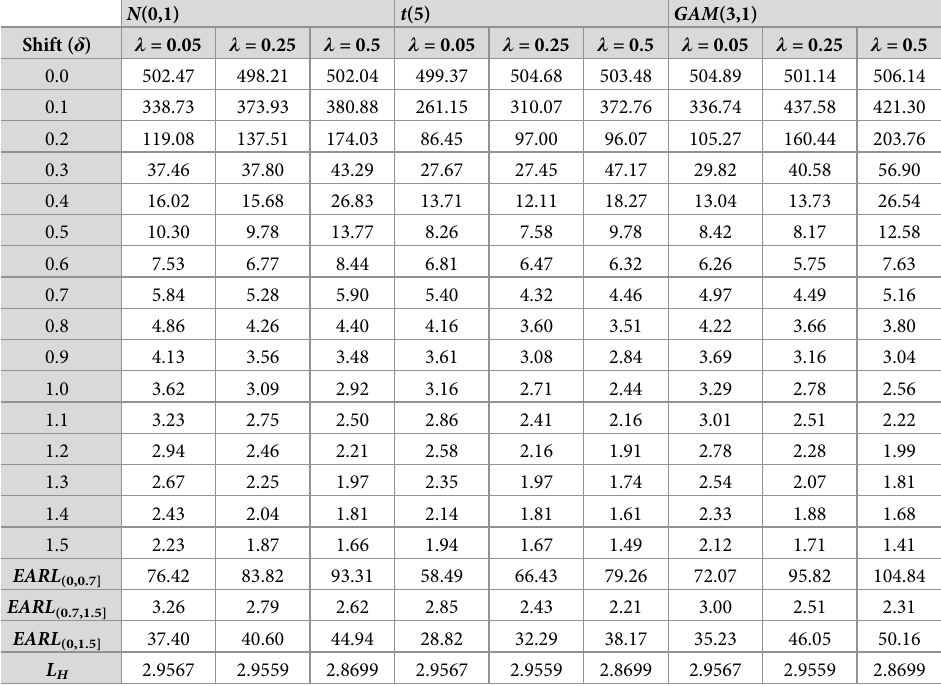
Table 2. The ARL profile of the HWMA W scheme when ( m , n ) = (100,5) and λ 2 {0.05, 0.25, 0.5} for a nominal ARL 0 = 500 under N (0,1), t (5) and GAM (3,1)